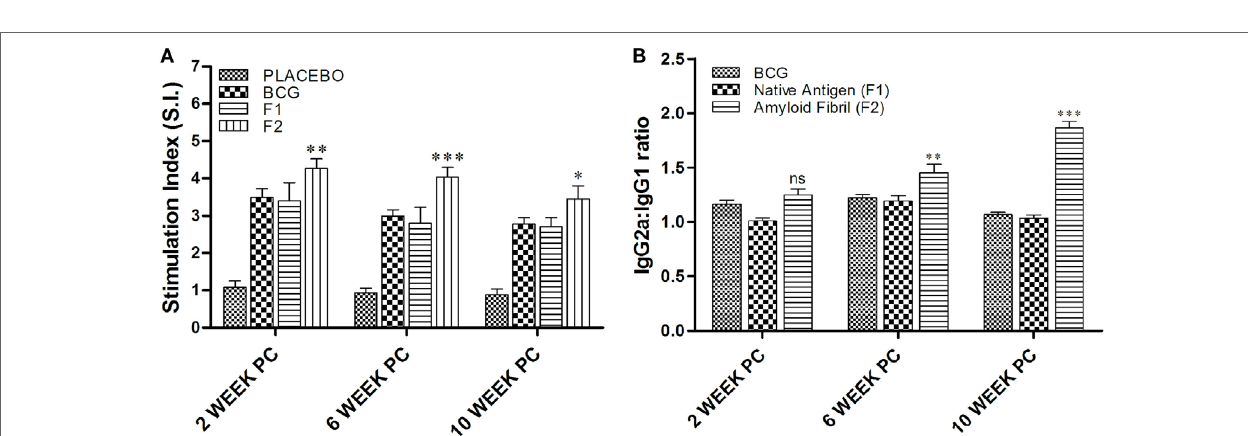
FigUre 5 | Evaluation of splenocyte proliferation potential and antibody isotype switching. (a) In vitro splenocyte proliferation response as deduced by MTT assay. At various time points post challenge, lymphocyte proliferation assay was performed to measure antigen-specific T lymphocyte proliferation. Lymphocytes isolated from various experimental groups were stimulated with corresponding set of matching antigens for 72 h. MTT solution (100 μ l/well) was added in last 4 h (of incubation), and the proliferation induced was measured as described in Section “Materials and Methods.” The results presented are means ( ± SEM) of Stimulation Index (SI) from three independent experiments. The data were analyzed by two-way ANOVA following by Bonferroni’s multiple comparison test where; p < 0.05(*), p < 0.01(**), and p < 0.001(***) were considered significant. (B) Antibody isotype switching in response to immunization with aggregated Ag85B. The isotype switching upon immunization with Ag85B aggregate was analyzed by ascertaining IgG2a and IgG1 isotypes in the sera employing sandwich ELISA and presented as ratio of the ODs obtained for IgG2a and IgG1. The data were analyzed by employing two-way ANOVA followed by Bonferroni’s multiple comparison test and are shown as the means ( ± SEM) of three independent determinants where; p < 0.05(*), p < 0.01(**), and p < 0.001(***) were considered significant.